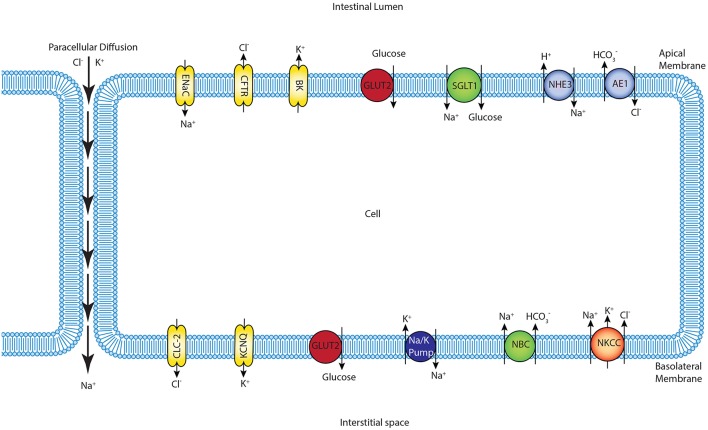
Schematic of enterocyte showing the relevant transporters in the apical and basolateral membrane along with the apical (lumen) and basolateral (interstitium) extracellular domains.